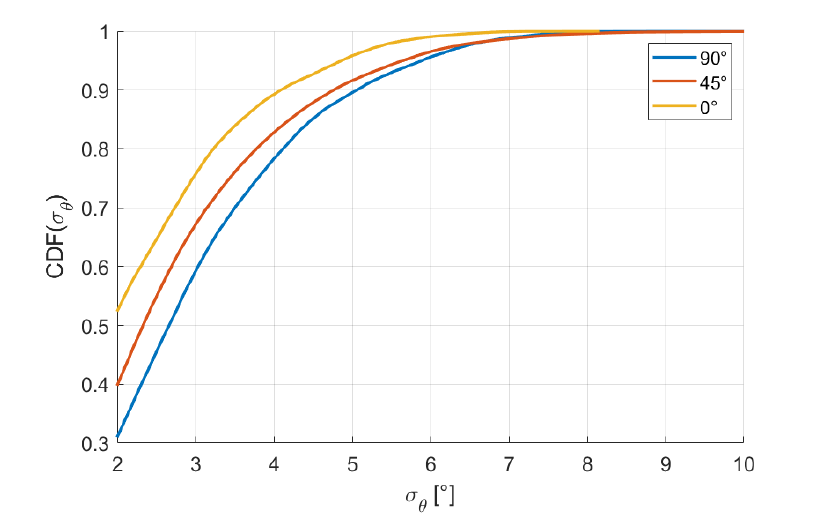
Figure 16. Cumulative distribution functions of σ θ for elevations 90 ◦ , 45 ◦ , and 0 ◦